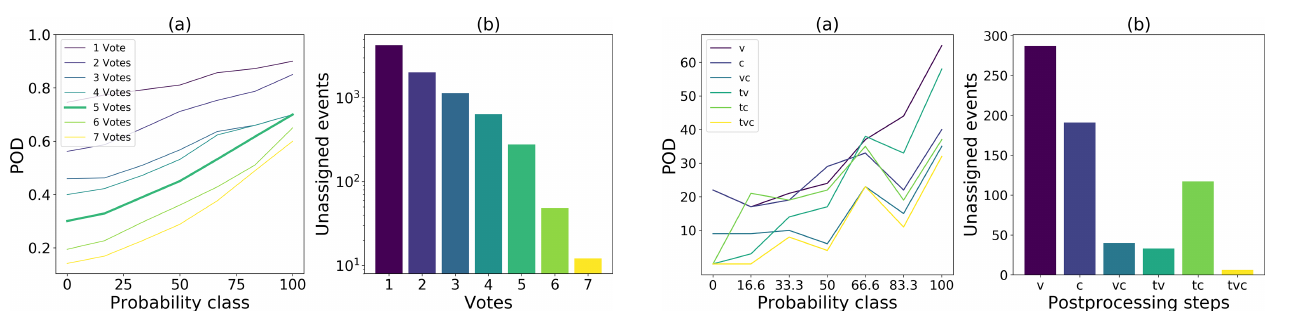
Figure 10. (a) POD for each probability class depending on the minimum number of votes (colors). (b) Number of unassigned events for different number of votes (colors).